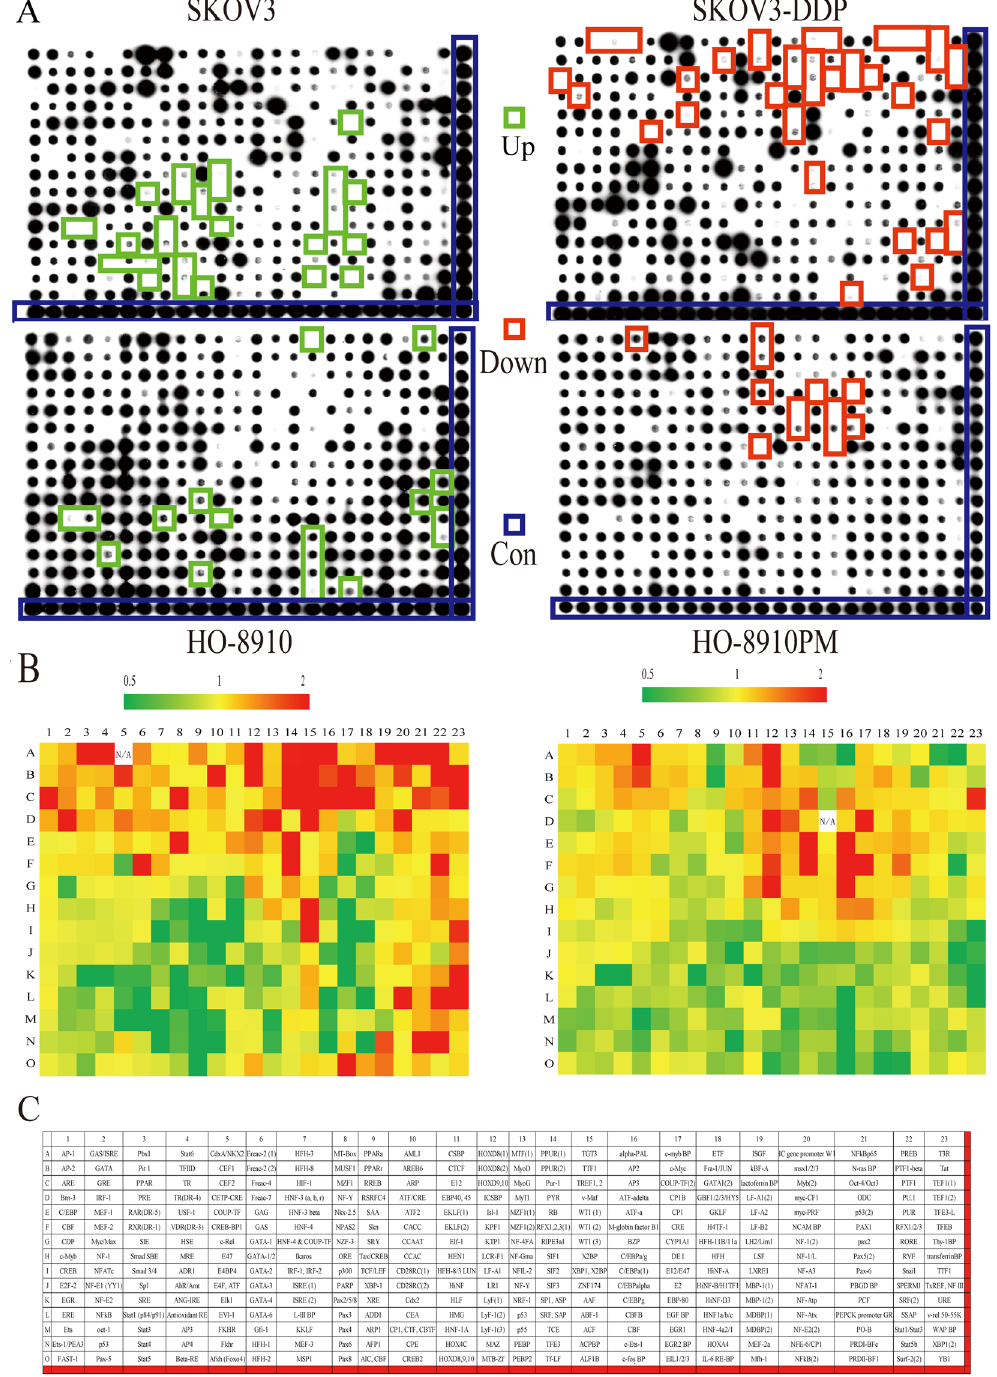
Figure 2. Different activity of transcription factors in protein/DNA arrays. As seen on the X-ray film ( A ), some transcription factor activities were up-regulated (red boxes) and some were down-regulated (green boxes) in two pairs of ovarian cancer cells. Three hundred forty-five transcription factors were observed ( B ). A heat map of SKOV3-DDP/SKOV3 (left) or HO-8910PM/HO-8910 (right) of different transcription factors ( C ). If the colour was closer to red, the transcription factor activity was higher. In contrast, the colour closer to green indicated lower activity. N/A meant there were no transcription factor activities in HO-8910 or SKOV3 cell